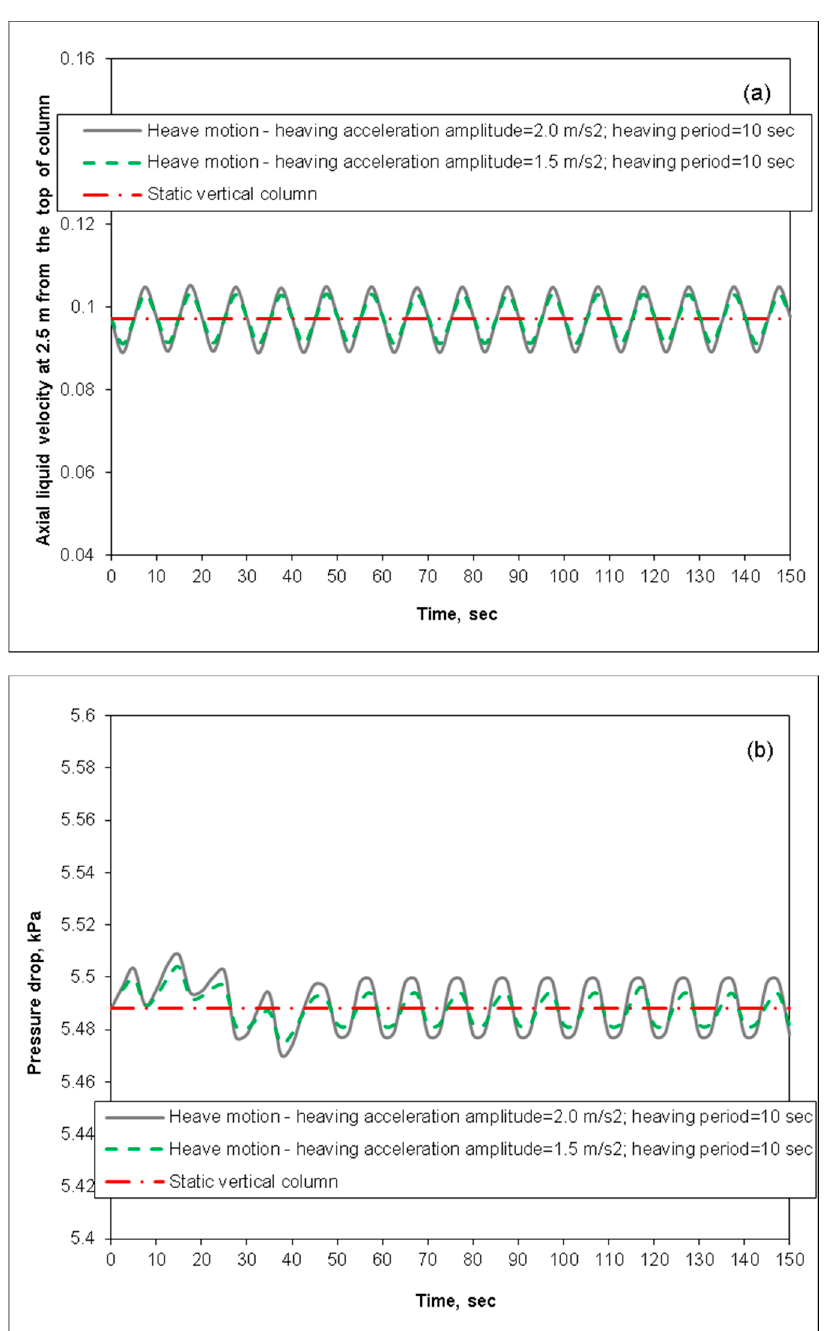
Figure 17. Time-dependent cross-sectionally averaged axial liquid velocity ( a ) and two-phase pressure drop ( b ) in a seawater scrubber under heaving motion conditions at different heaving acceleration amplitudes (Packed-bed column with Raschig super-Rings; H = 5 m; Pressure = 1.5 MPa).